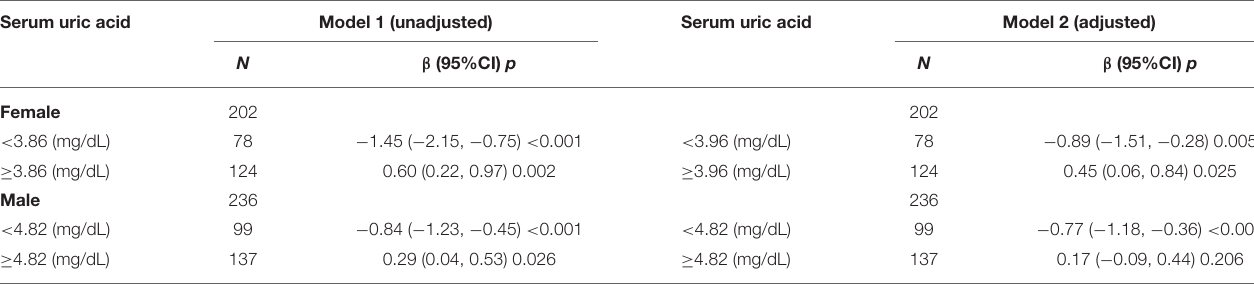
Model 1: unadjusted. Model 2: adjusted for age, hypertension, CHD, platelets, neutrophils, albumin, fasting blood sugar, creatinine, ESR, prothrombin time, lipid-lowering drugs, and antiplatelet drugs. SUA, serum uric acid; RDW, red blood cell distribution width; CHD, coronary heart disease; ESR, erythrocyte sedimentation